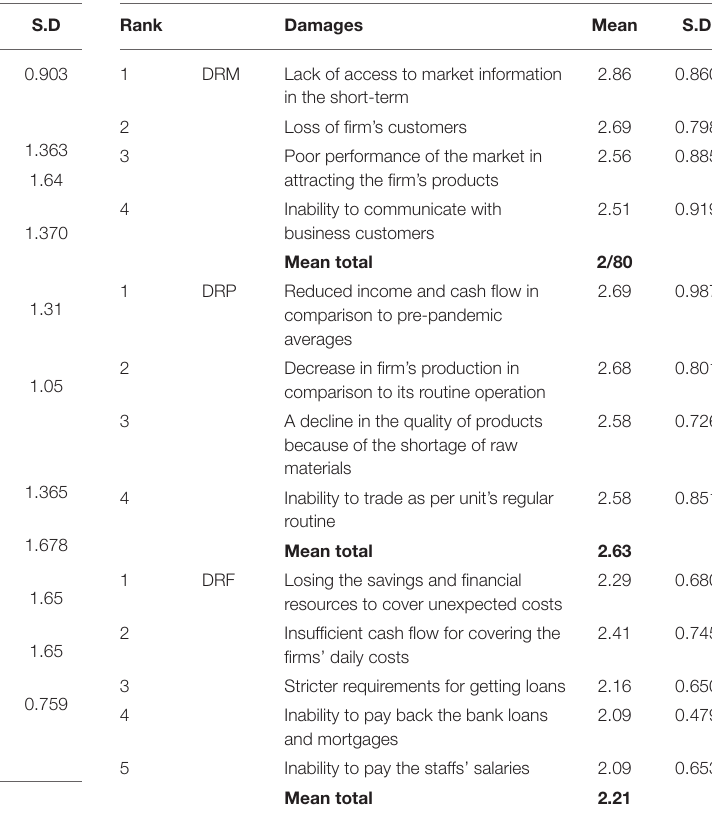
TABLE 5 | Mean and ranking of adaptive and passive behaviors in closed MSEs. Rank